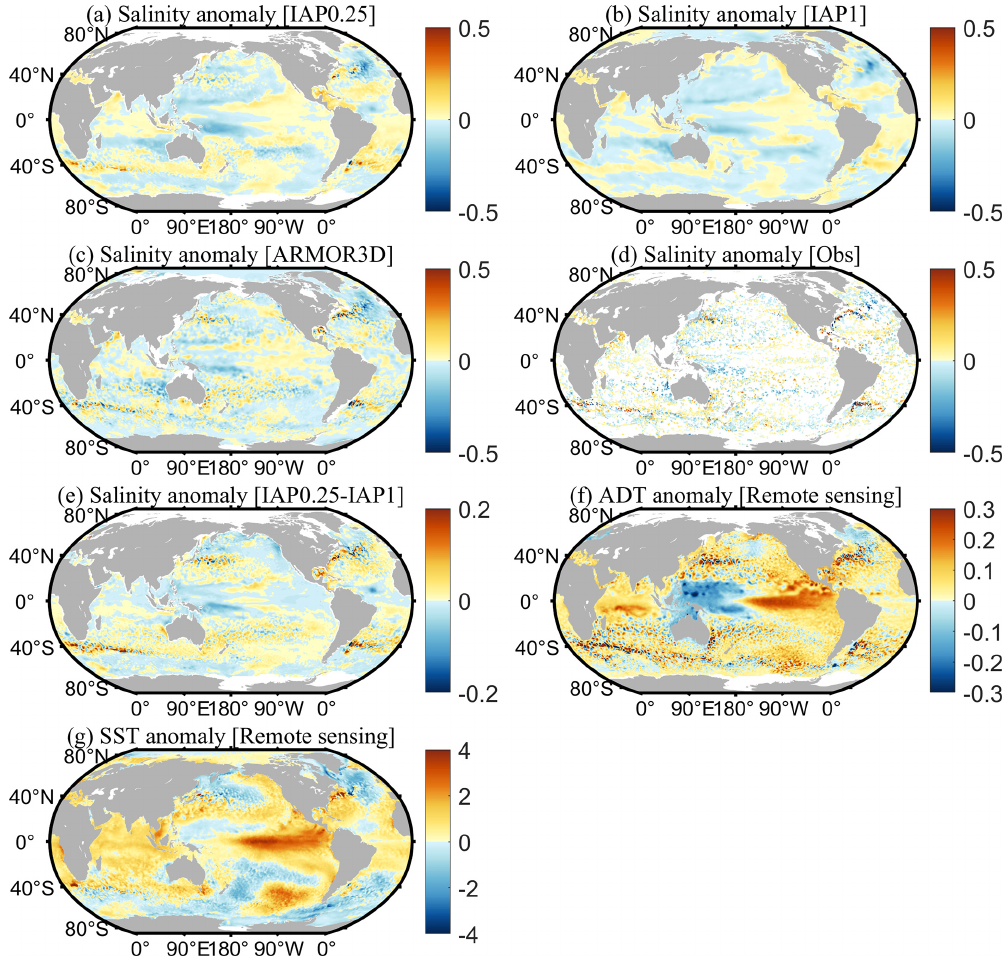
Figure 4. Spatial distribution of salinity anomalies of (a) IAP0.25 ◦ , (b) IAP1 ◦ , (c) ARMOR3D, (d) in situ observations, and (e) IAP0.25 ◦ minus IAP1 ◦ at 300m, as well as the spatial distribution of (f) ADTA and (g) SSTA in January 2016.